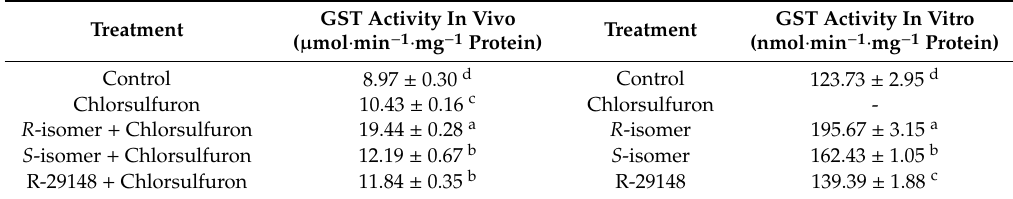
Table 2. E ff ects of safeners and chlorsulfuron on the activity of glutathione S-transferase (GST) in maize.